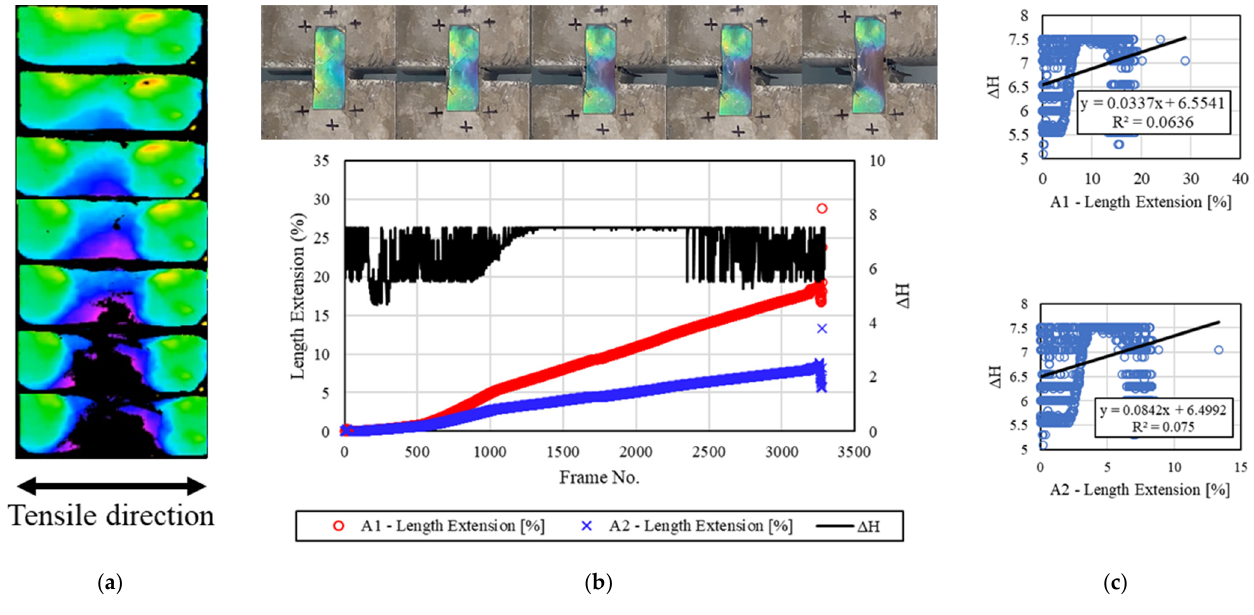
Figure 12. Results for the specimens after 3.5 h. ( a ) H-value image for discoloration color of mechanochromic sensor (90 ◦ rotation relative to tensile direction); ( b ) variations in strain and dH of A1 and A2 according to image frame. (The discoloration process of the mechanochromic sensor attached to the specimen and the tensile strain described in Figure 3 are shown.); ( c ) correlations of dH with A1 and A2.